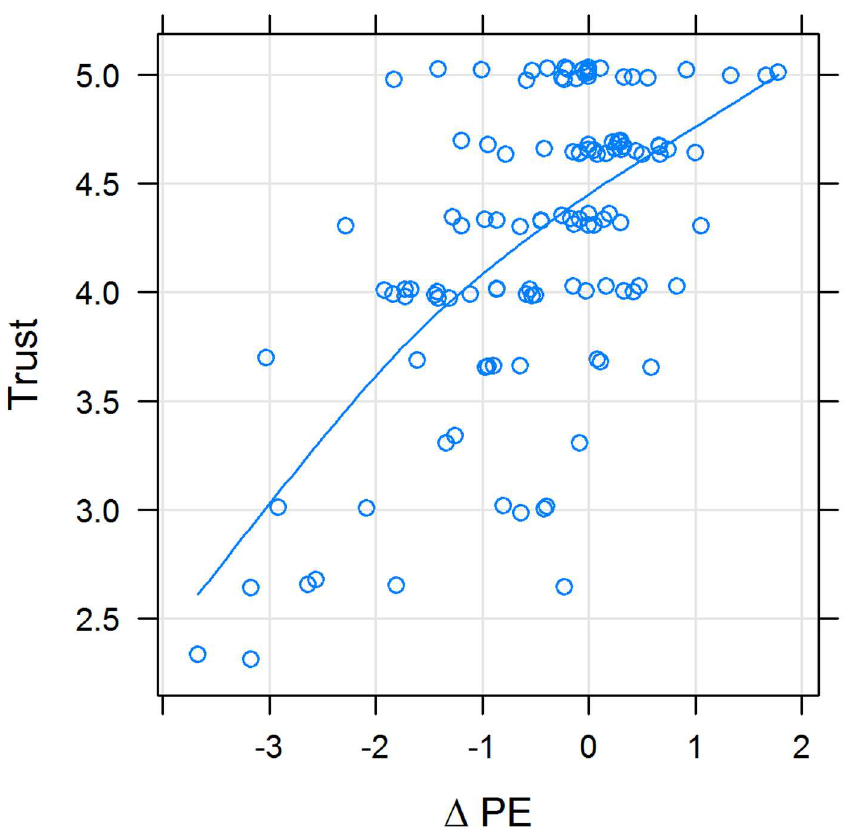
Fig 6. Association between trust in the physician (Trust) and the difference between desired and perceivedphysician empathy ( Δ PE); X-Y scatterplot. Variableswere positivelycorrelated (rho = 0.32; p < 10 − 7 ). The line represents a cubic smoothingspline